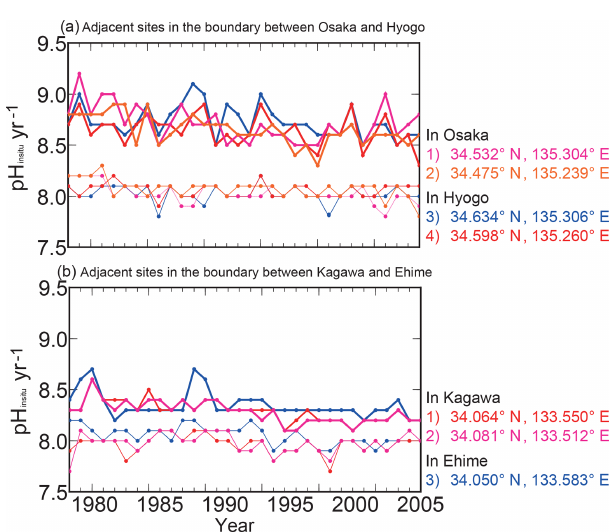
Figure 6. Examples of time series for annual minimum and maxi- mum pH insitu data at adjacent monitoring sites close to the bound- aries between (a) Osaka and Hyogo and (b) Kagawa and Ehime. Lines of the same color indicate data collected at the same site. Thin and bold lines indicate the annual minimum and maximum pH insitu data, respectively, at each monitoring site. Site locations are included to the right of each panel, with the text color corre- sponding to the colors in each